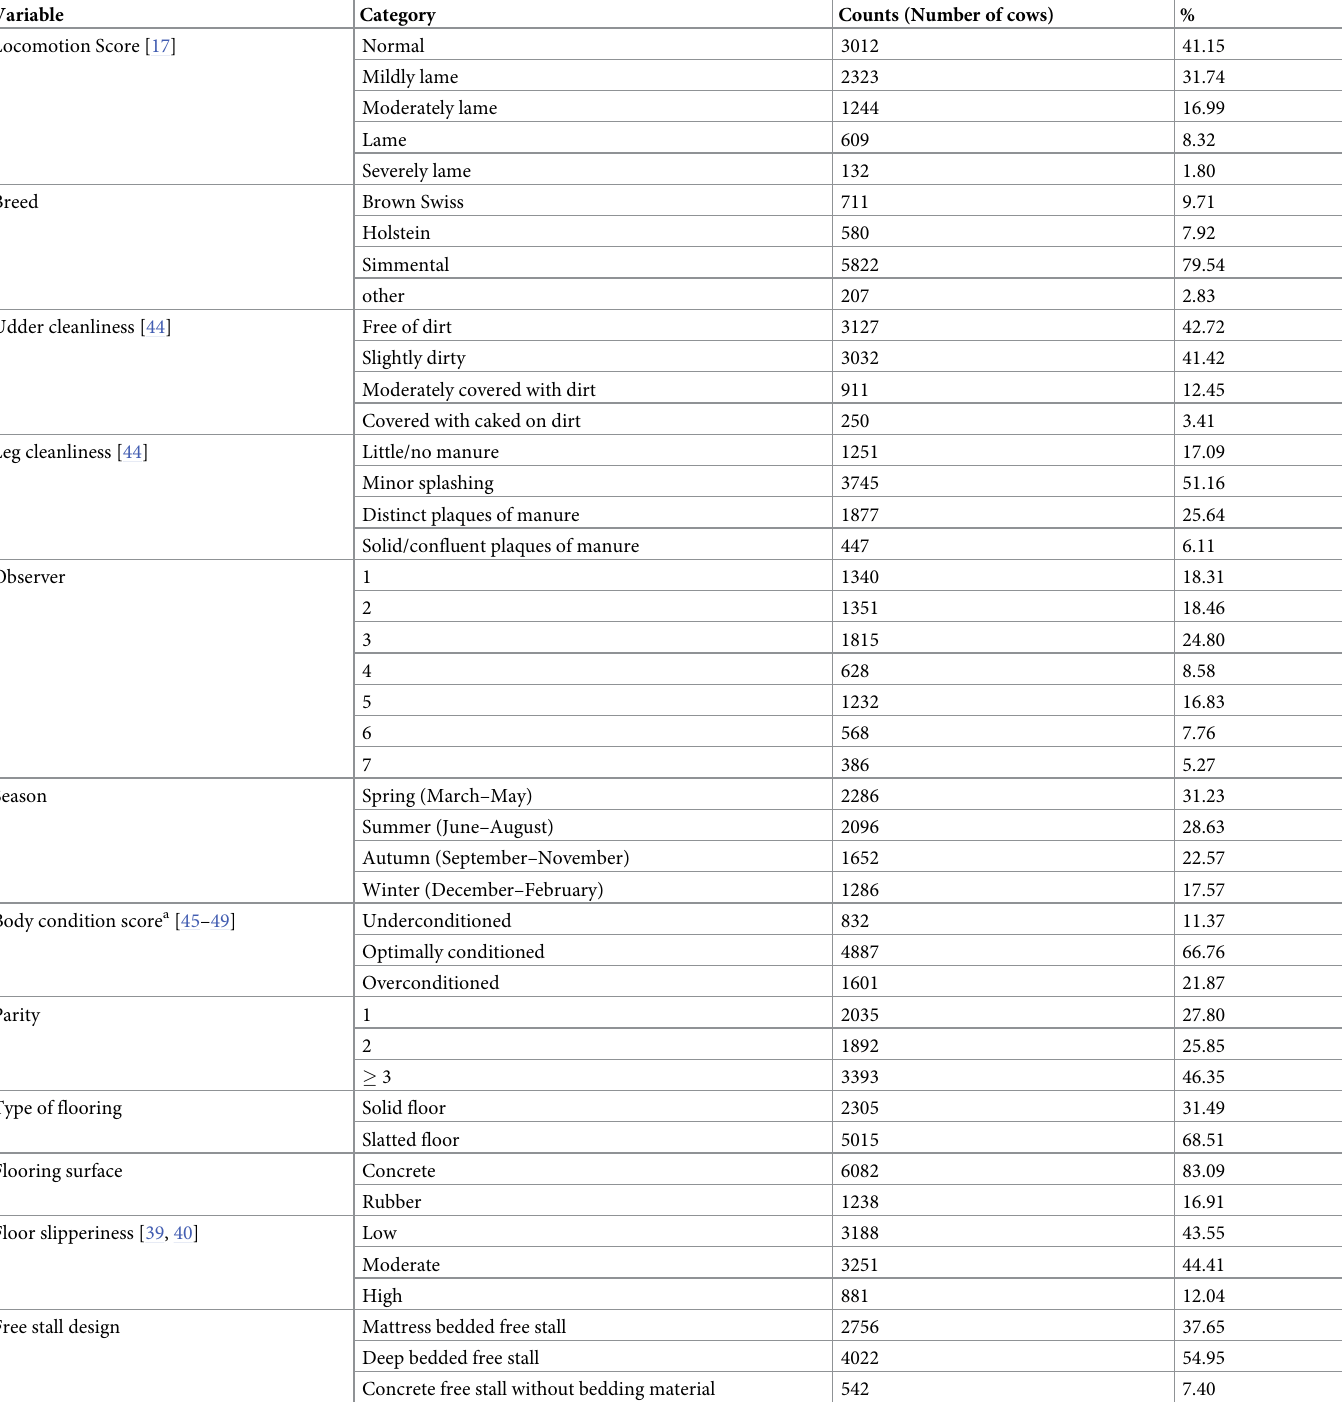
Table 1. Animal-level descriptive statistics (number of cows per category and ratio) of categorical variables within the final, complete cases data set for analysis (7,320 cows on 166